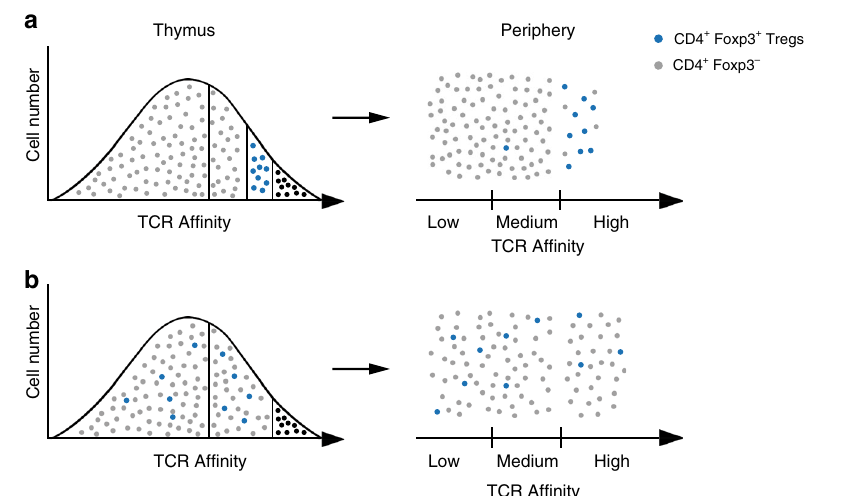
Fig. 8 Abundance of autoreactive CD4 + T cells-current and proposed hypotheses. a Current paradigm: Only thymocytes that TCRs weakly bind class II MHC/ self-peptide complexes differentiate as CD4 + Foxp3 − cells (gray dots). Thymocytes that express autoreactive TCRs are deleted by negative selection (black dots) or become CD4 + Foxp3 + Tregs (blue dots). (cid:129) Negative selection infrequently misses CD4 + Foxp3 − cells with autoreactive TCRs. (cid:129) In the periphery, Tregs control few (1-4%) autoreactive CD4 + Foxp3 − cells. In Tregs de fi cient mice these rare CD4 + Foxp3 − cells clonally expand causing autoimmunity. (cid:129) Tregs only complement central tolerance. (cid:129) Autoreactivity is a nuance of TCR repertoire of peripheral CD4 + Foxp3 − cells but is a common feature of CD4 + Foxp3 + repertoire. b Proposed model: Approximately 1/3 of mature CD4 + Foxp3 − cells express autoreactive TCRs. A considerable portion of CD4 + Foxp3 − cells are selected by agonist self-peptides. (cid:129) Negative selection fails to delete a substantial portion of thymocytes expressing potentially autoreactive TCRs. (cid:129) In Tregs de fi cient mice autoimmunity involves polyclonal activation of CD4 + Foxp3 − cells by ubiquitous self-peptides. (cid:129) Central tolerance and Tregs have an equal role in preventing autoreactivity. (cid:129) Autoreactive TCRs are expressed at similar frequencies by CD4 + Foxp3 − and CD4 + Foxp3 + cells. TCR self-reactivity has a limited impact on CD4 + cells lineage